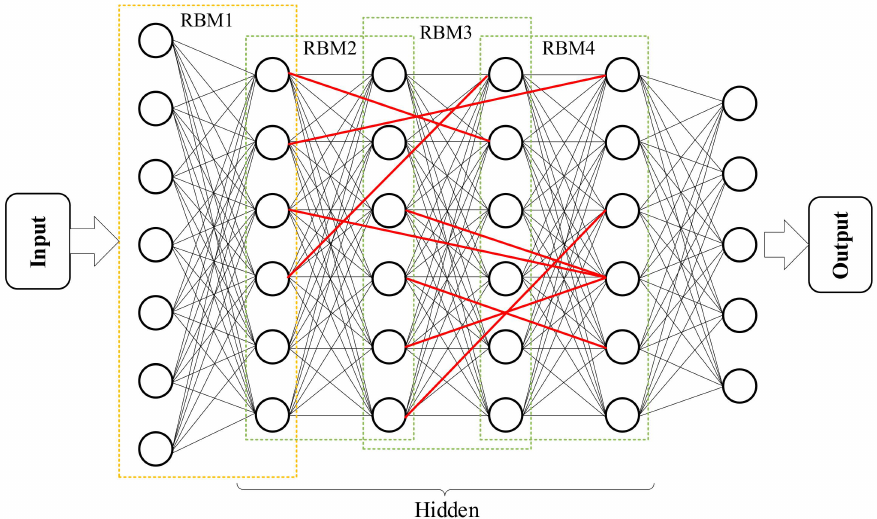
Figure 1. Structure of the deep small-world neural network (DSWNN)